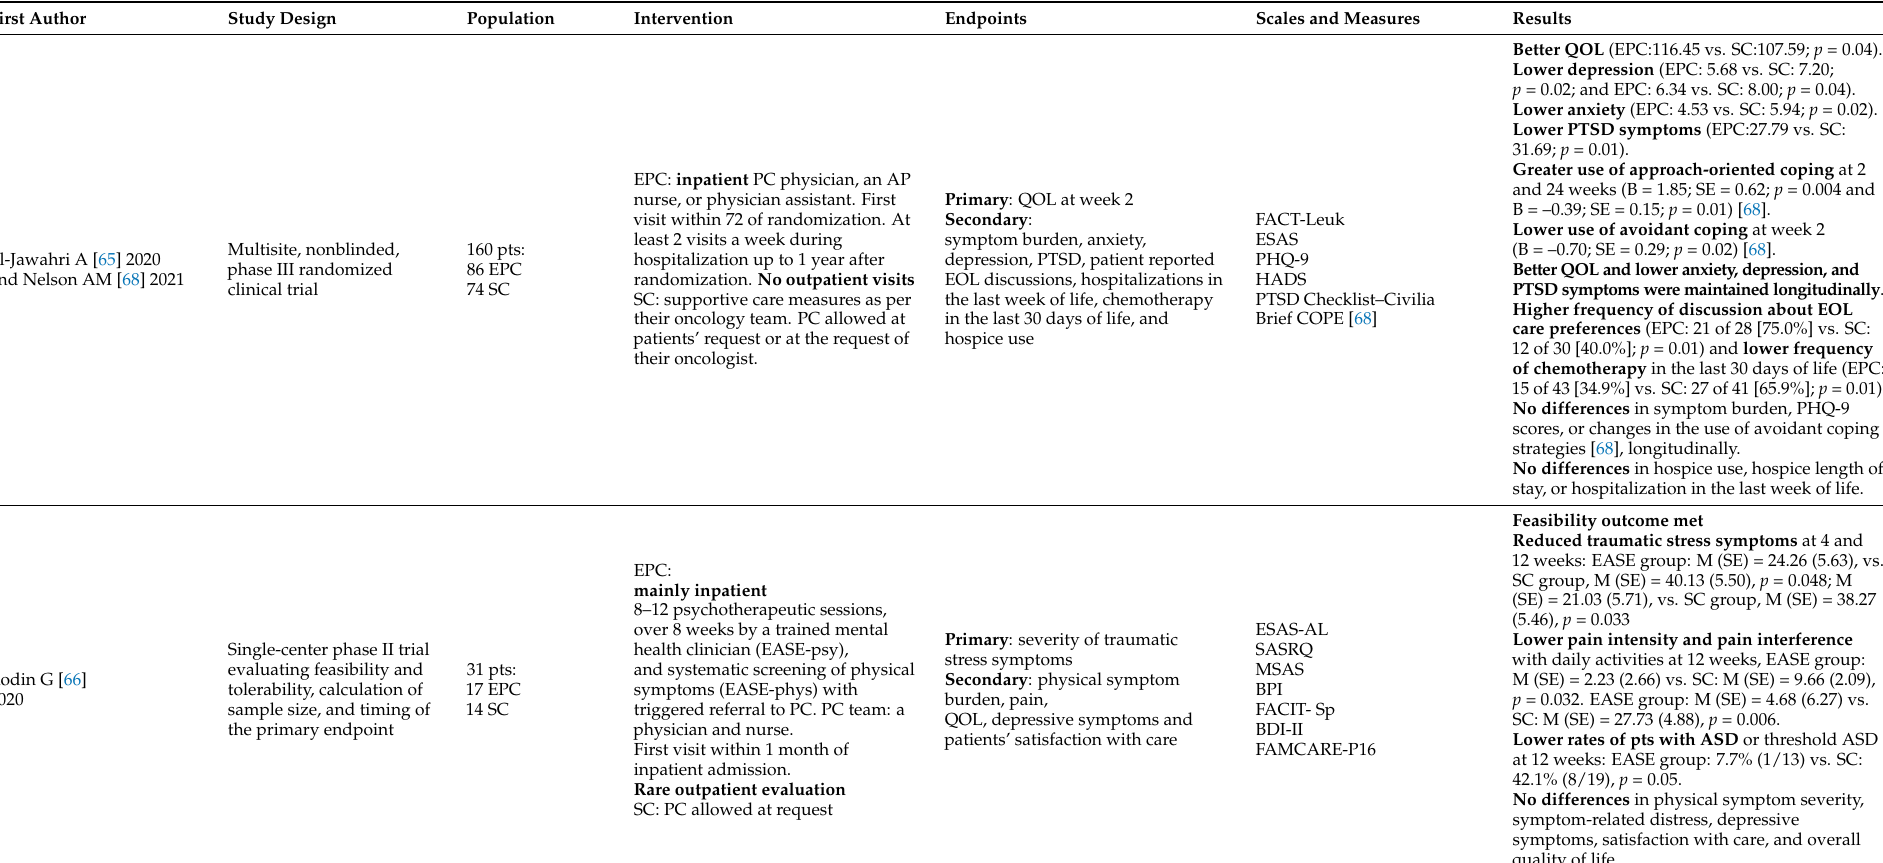
Table 1. Studies evaluating the early integration of palliative care in patients with acute myeloid